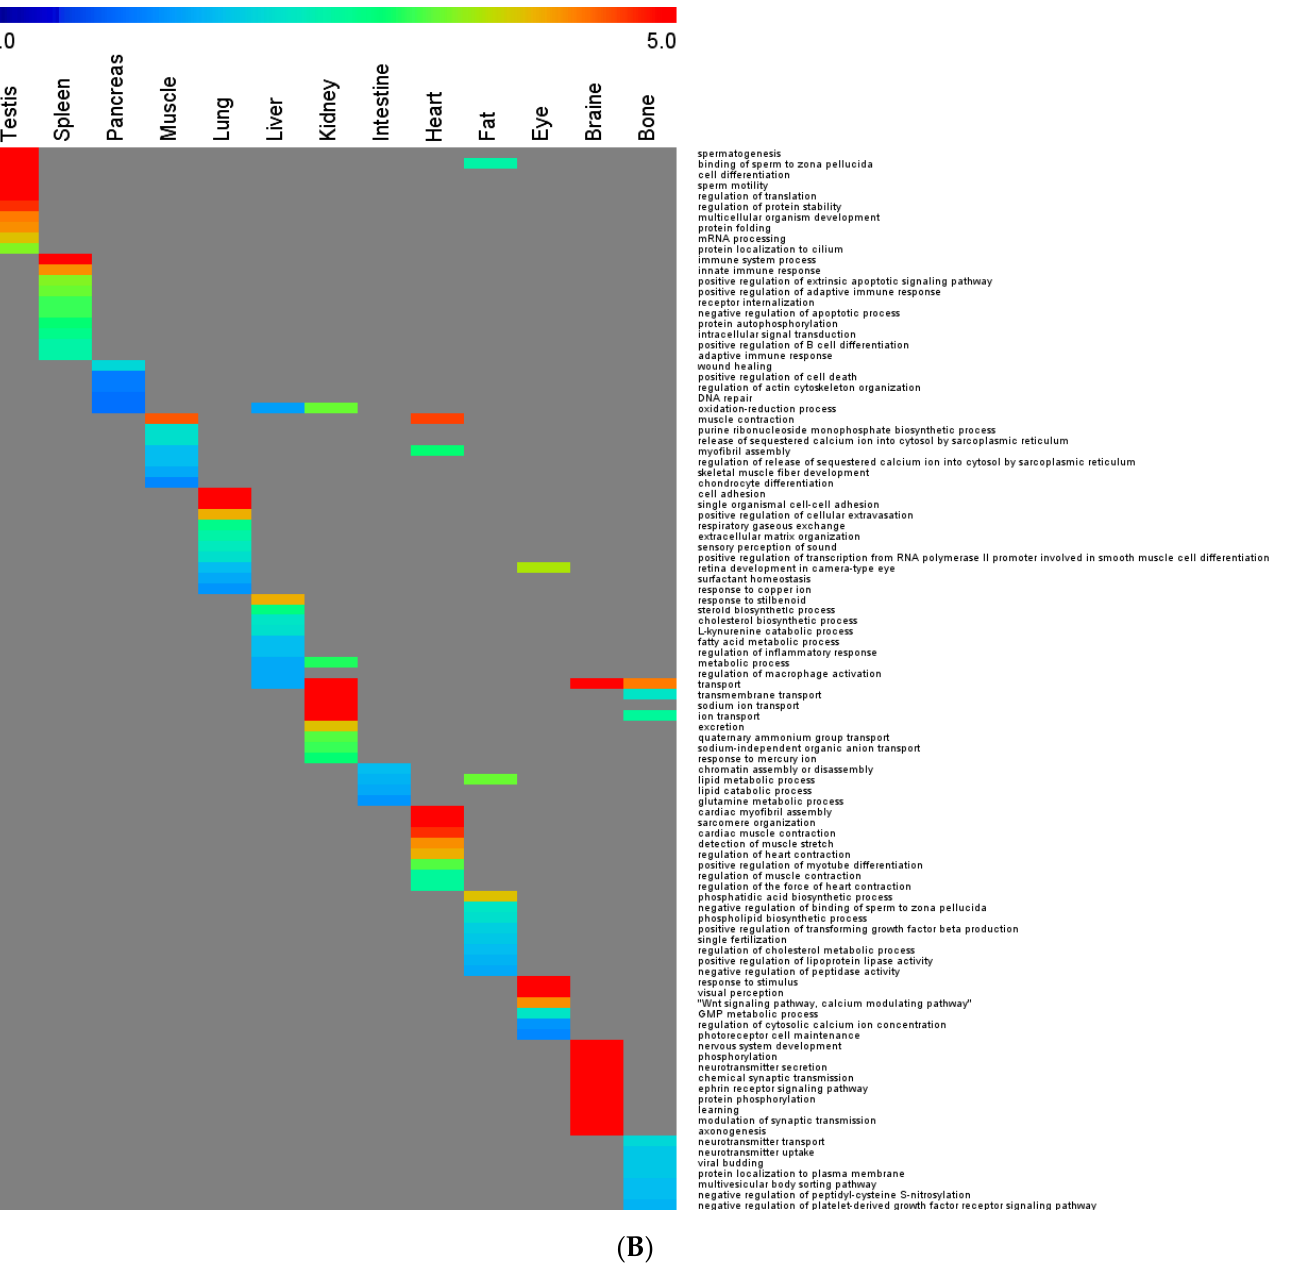
Figure 4. Gene ontology enrichment analysis of biological processes in the panorgan proteome of BL6. ( A ) Enrichment analysis of the pan-organ proteomes of top100 proteins. ( B ) Enrichment analysis of the organ-specific proteins.